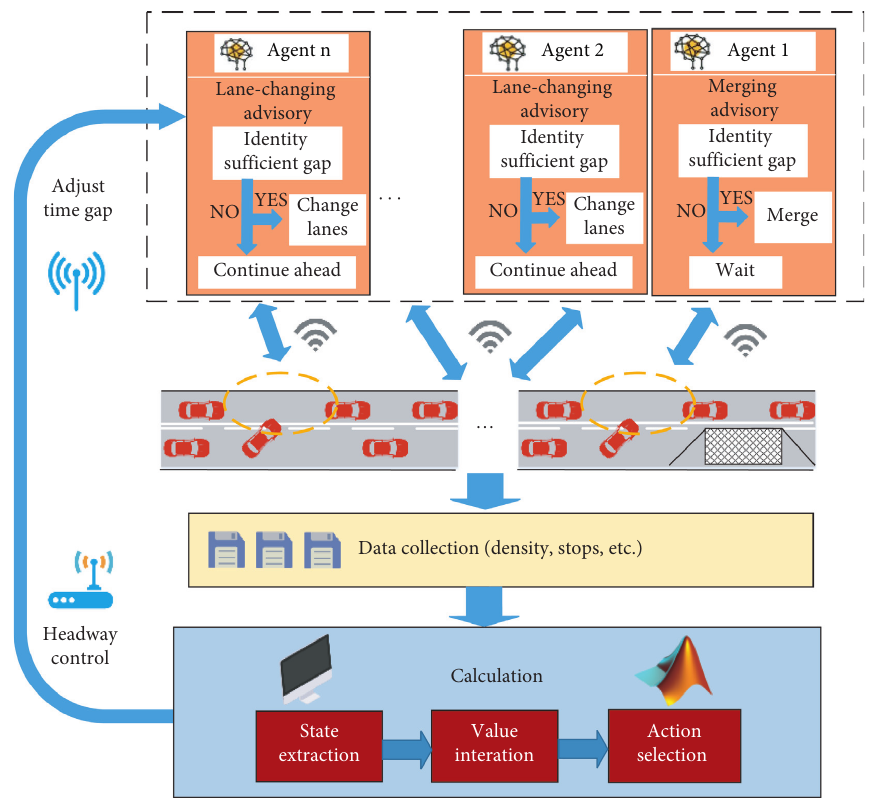
Figure 1: Variable headway execution